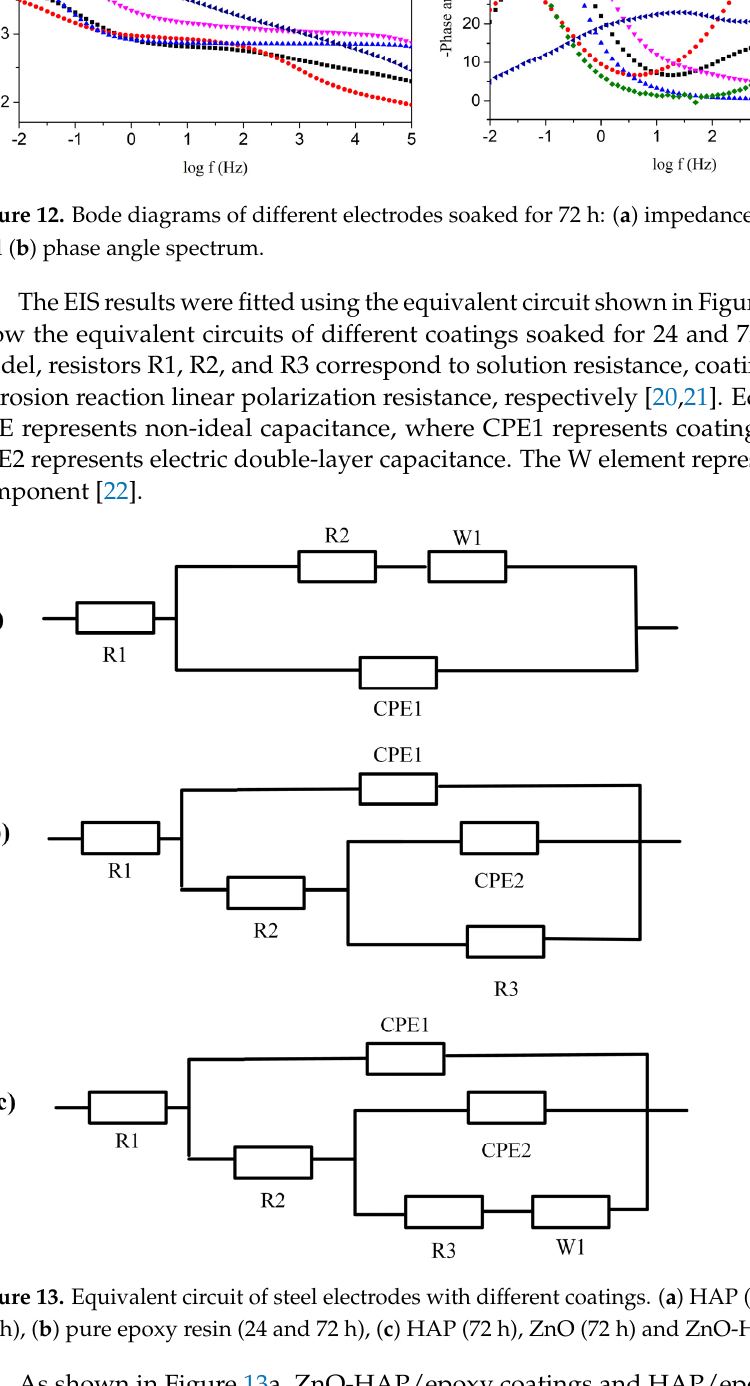
Figure 11. Bode plots of different electrodes soaked for 24 h: ( a ) impedance modulus spectrum and ( b ) phase angle spectrum.